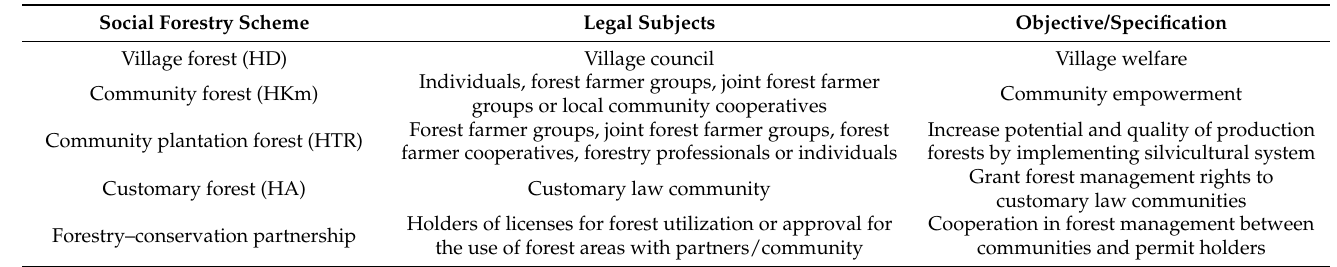
Table 2. Legal subjects granted access to manage forest area in various schemes of social